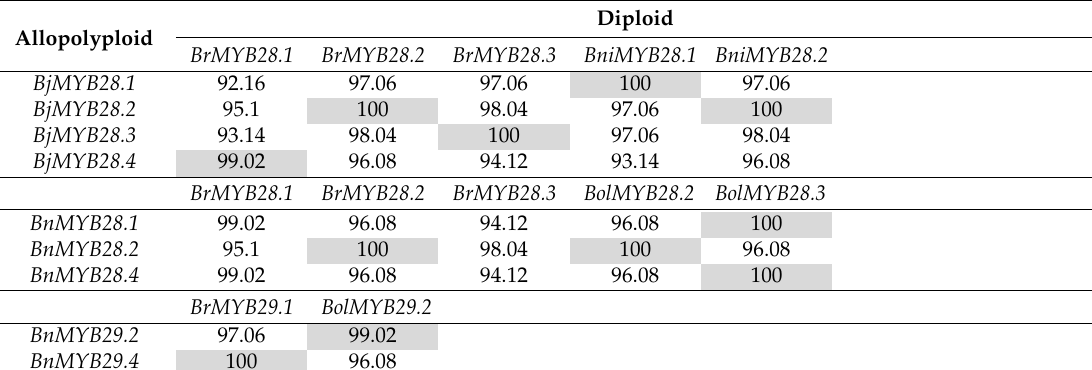
Figure 3. Phylogenetic analysis of R2R3 MYB DNA-binding domains in 55 MYB transcription factors involved in the glucosinolate biosynthesis pathway in Brassica species. This tree was constructed using MEGA, version 6, software [58]. Bootstrap values with 1000 replicates are denoted as percentages. At, A. thalinala ; Br, B. rapa ; Bni, B. nigra ; Bol, B. oleracea ; Bn, B. napus ; Bj, B. juncea . Table 2. Amino acid sequence identity (%) for the allopolyploidy R2R3 MYB DNA-binding domains of diploidy genes of Brassica. Values represent the percentage of sequence similarity and highest percentage demarcated by the gray blocks.